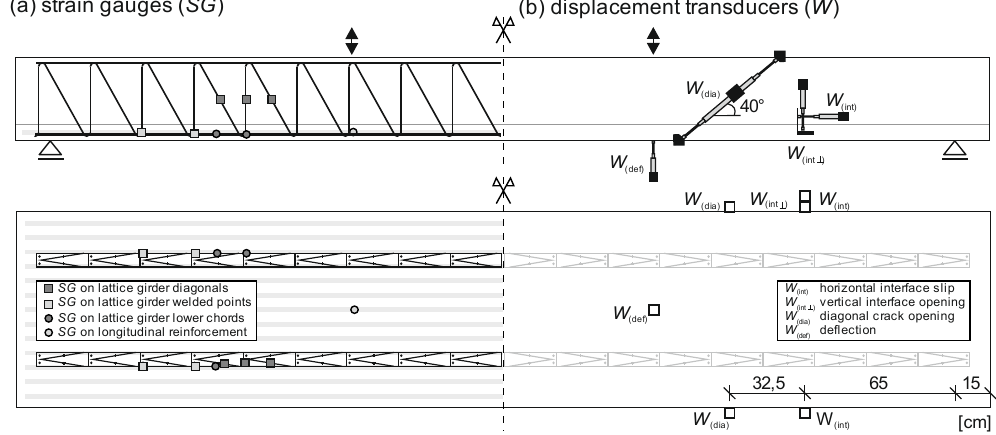
Figure 14. Measurement instrumentation for Specimen EG10: strain gauges (SG) at reinforcement and displacement transducers (W).